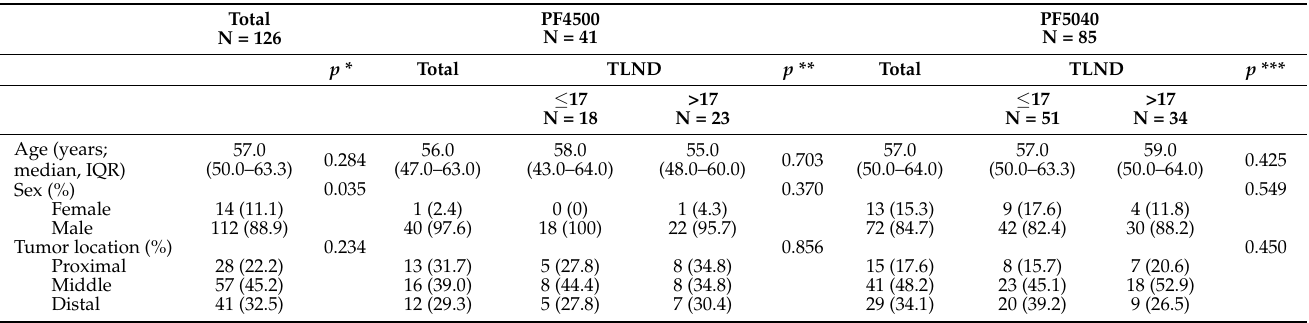
Table 1. Clinical characteristics of patients categorized by total LND number in the PF4500 and PF5040